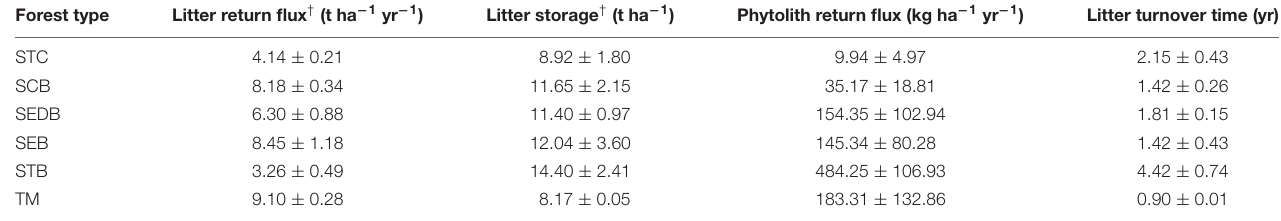
TABLE 3 | Phytolith return fluxes of forest litter layer in different forest types. Forest